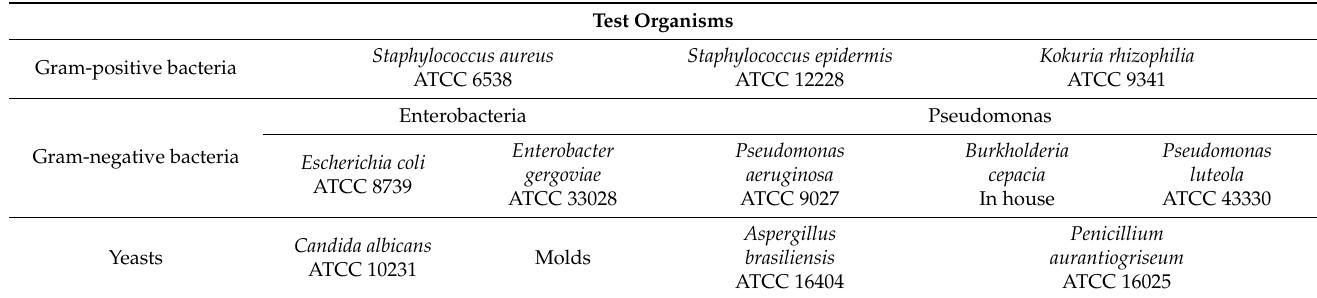
Table 3. Types of microorganisms tested.